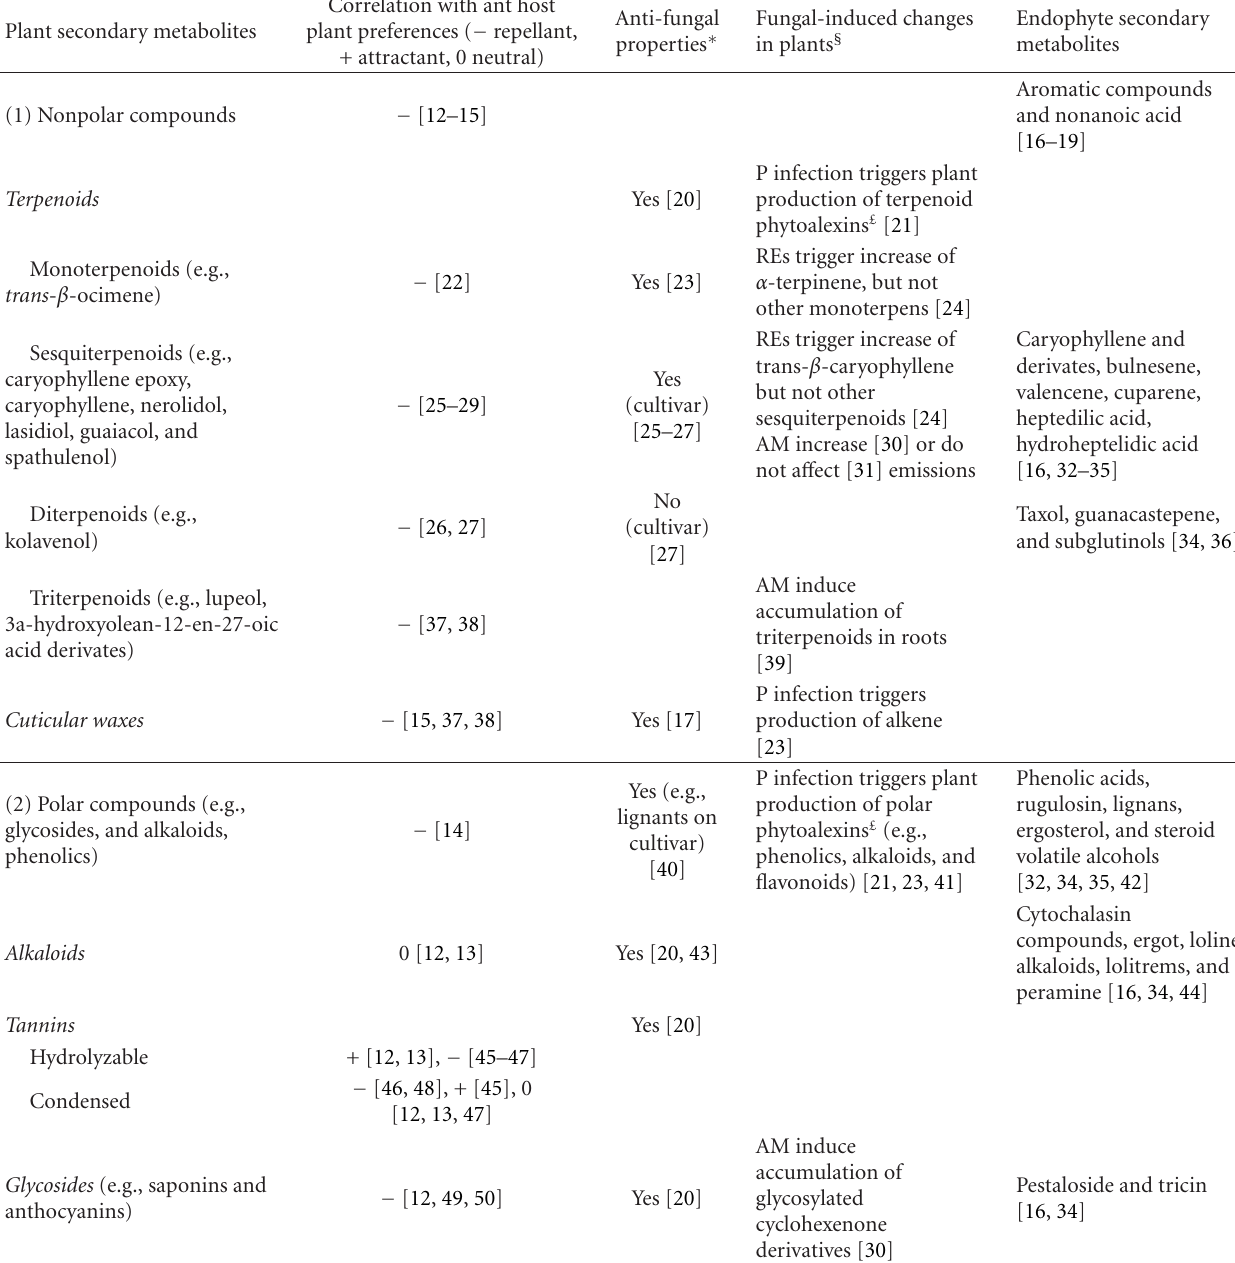
Table 1: A review of studies that correlate plant secondary metabolites with ant foraging preferences, with additional observations of whether these key families of compounds have antifungal properties, change as a result of plant-fungal interactions, or are known to be produced in in vitro endophyte